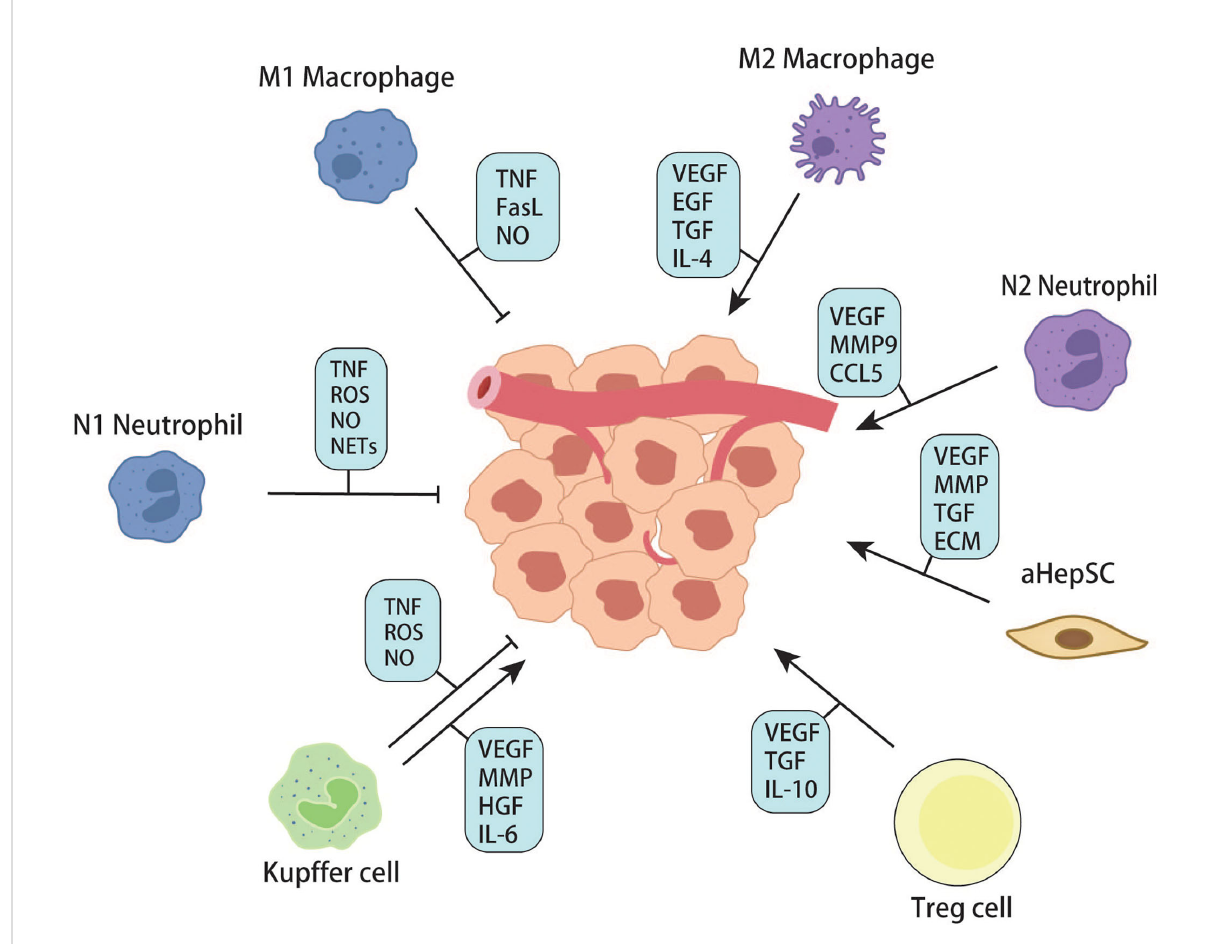
FIGURE 6 Effects of cells in liver microenvironments on metastatic